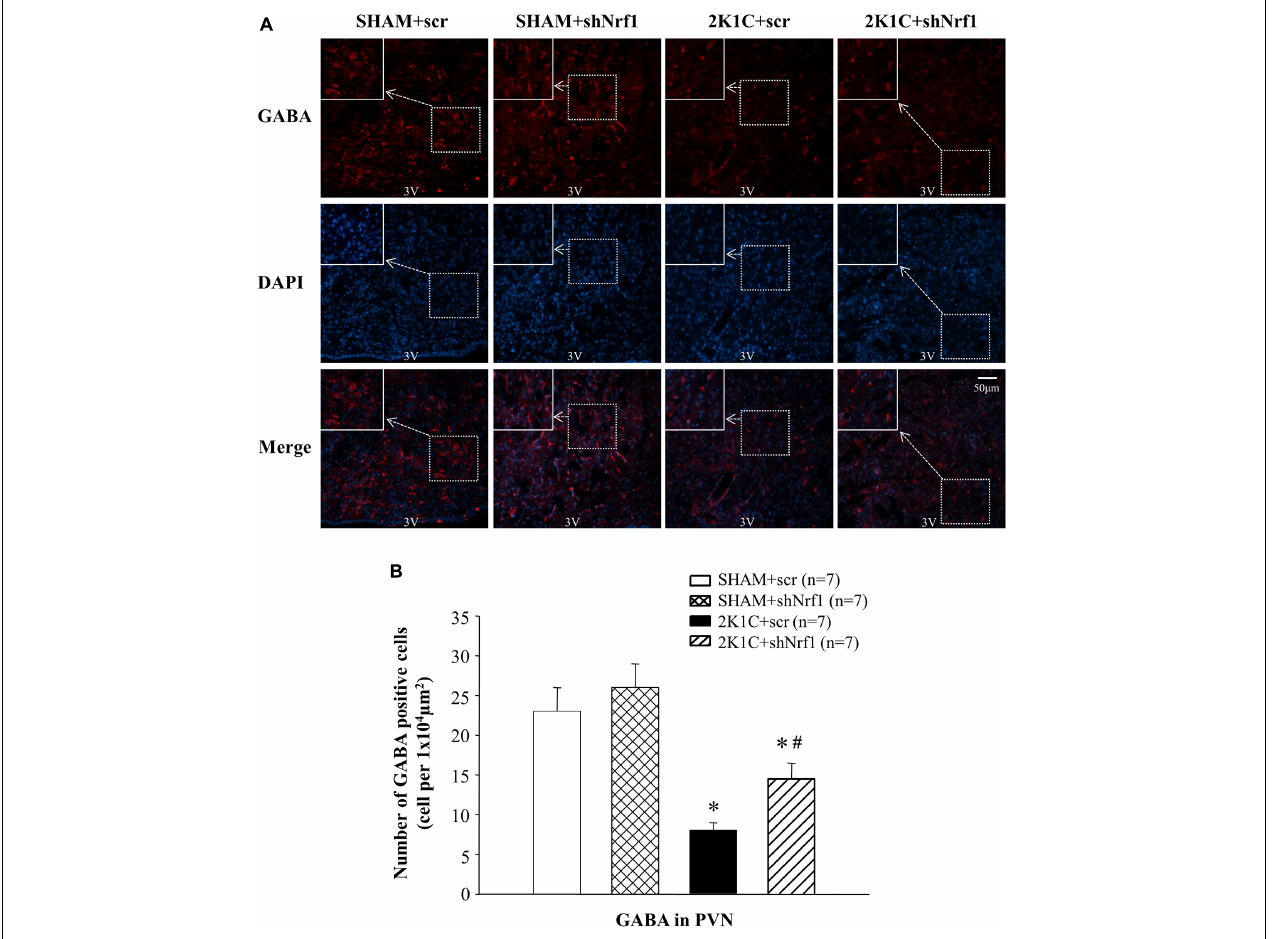
FIGURE 7 | Effects of knocking down of Nrf1 on GABA expression in PVN of hypertensive rats. (A) Immunofluorescence for the expression of GABA in PVN in different groups. (B) Changes of the number of GABA positive cells in PVN. ∗ P < 0.05 vs. control animals (SHAM + scr or SHAM + shNrf1). # P < 0.05 2K1C + shNrf1 vs. 2K1C +